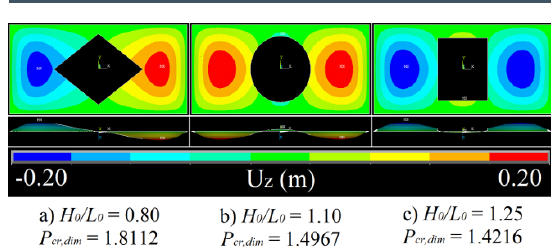
Figure 11. Buckledshapeofdiamondperforatedplatewithholevol- ume fraction of 0.20.